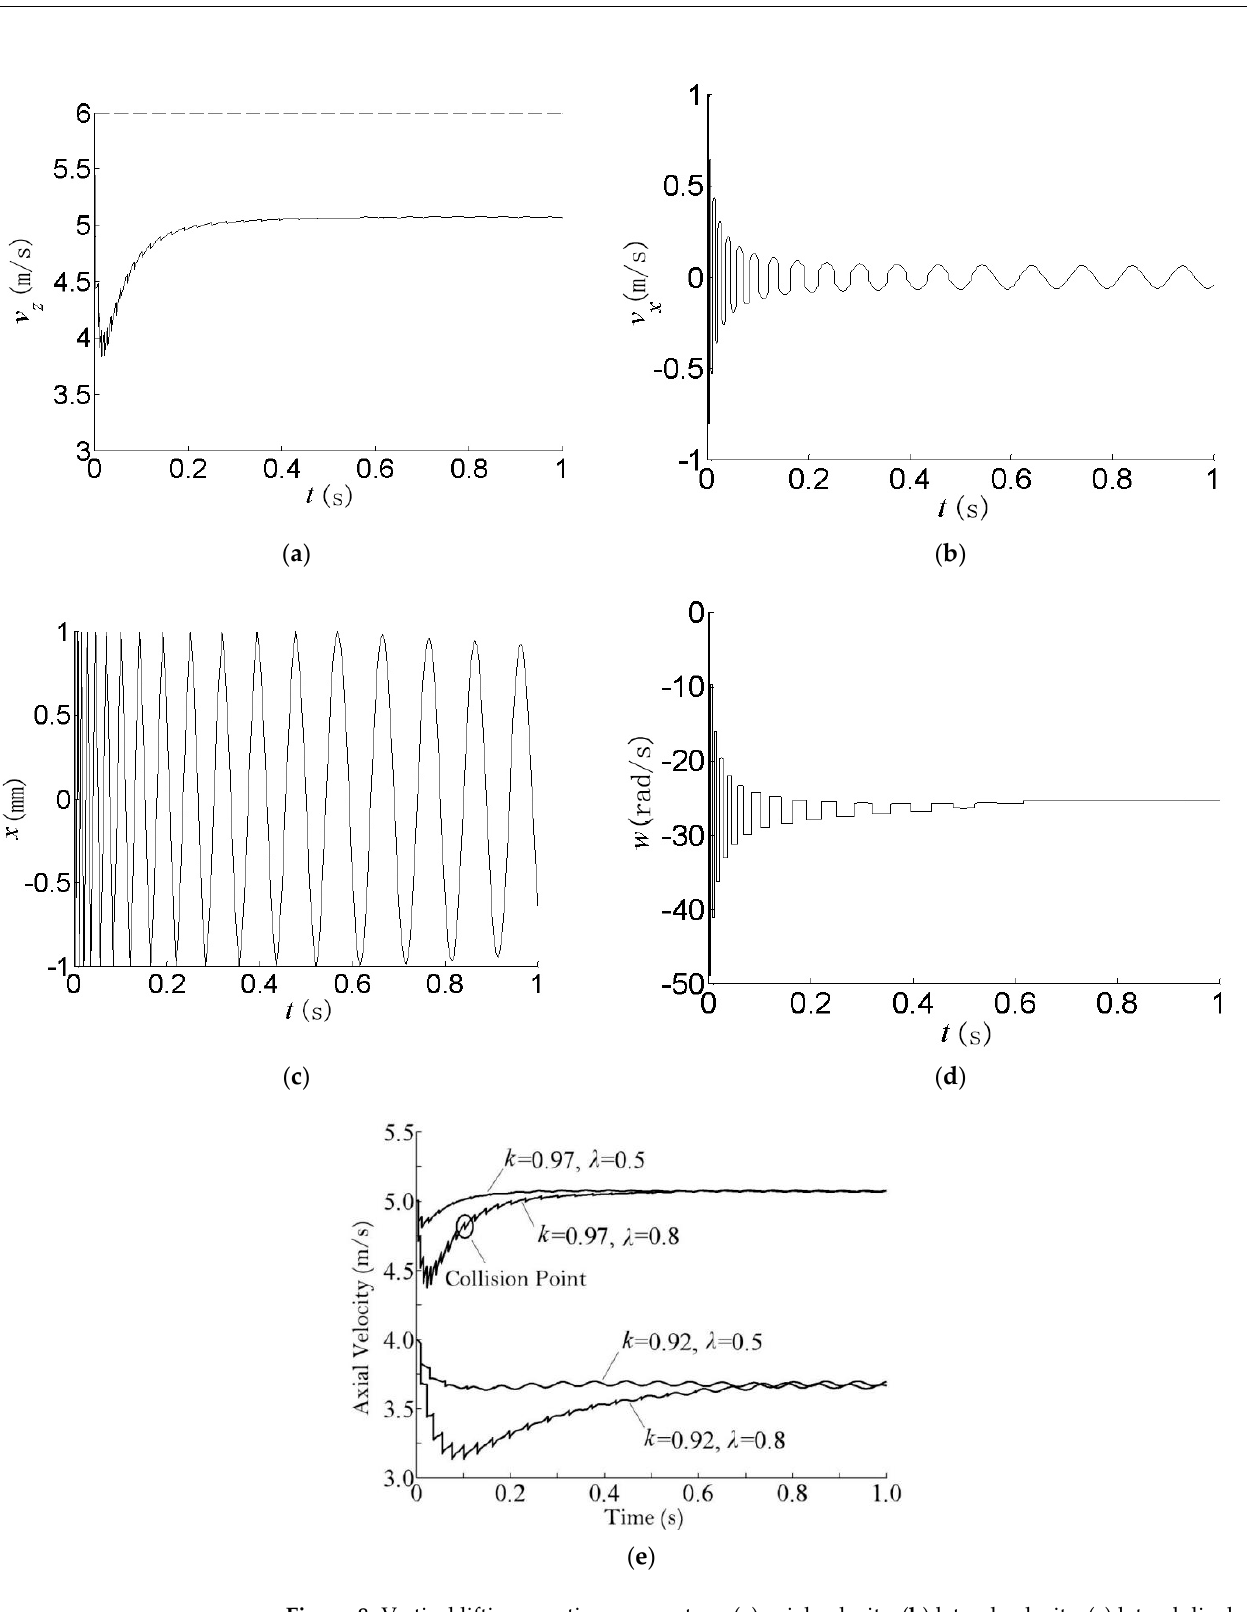
Figure 8. Vertical lifting − section parameters: ( a ) axial velocity, ( b ) lateral velocity, ( c ) lateral displacement, ( d ) angular velocity, ( e ) sphere/pipe − diameter ratio and recovery factor.